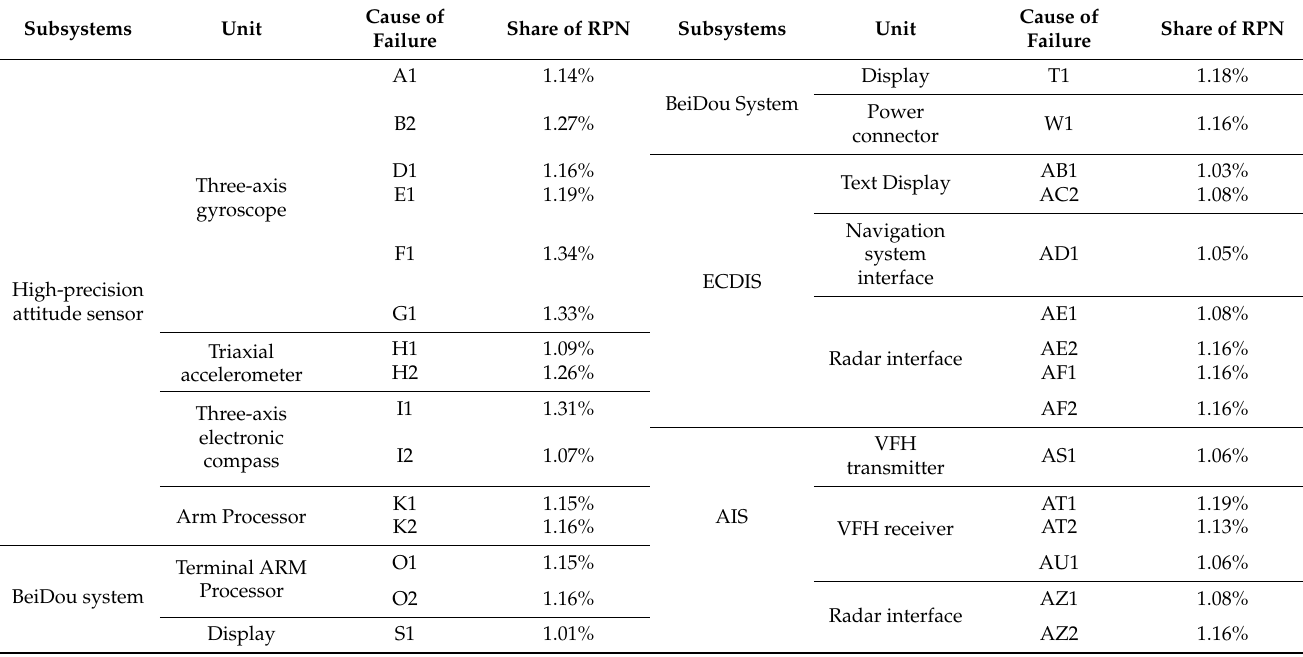
Figure 4. Box diagram of the positioning system RPN. Table 3. Critical failure causes of the positioning